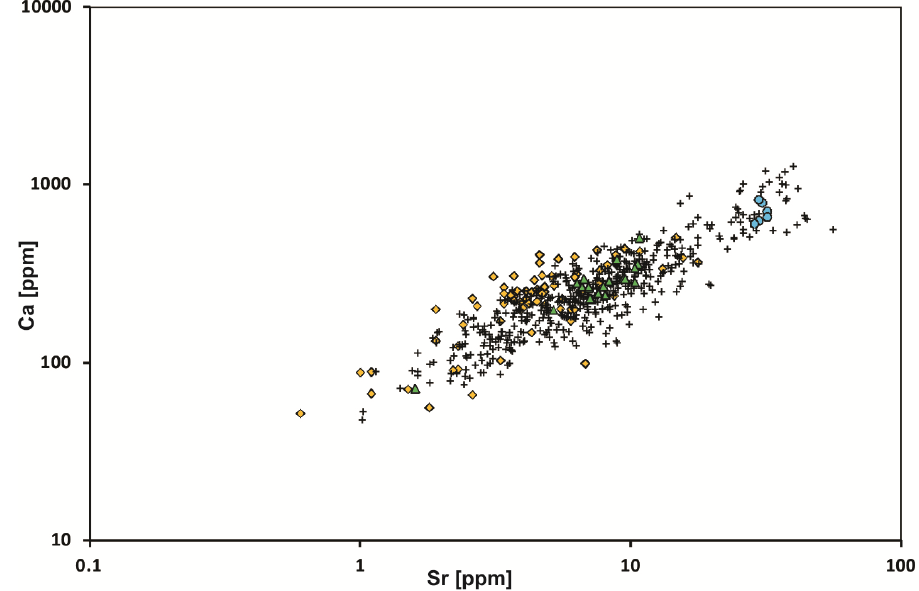
Figure 6. Binary plot of Ca and Sr concentrations showing positive correlation. Please note that the element concentrations are displayed on the logarithmic scale. Gifurwe = yellow diamonds, Nyakabingo = black crosses, Bugarama: type-2 = green triangles and type-3 = blue circles; concentrations of type-1 are below the detection limits of both